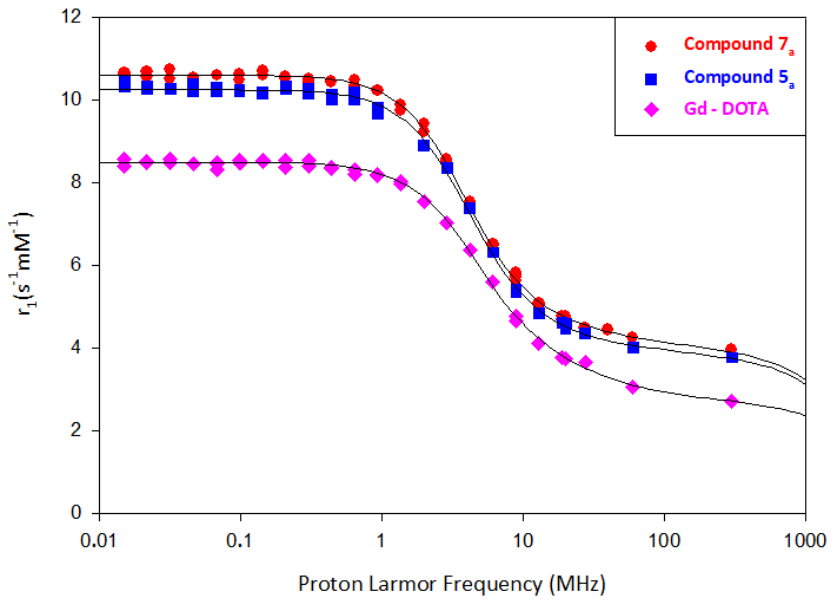
Figure 1. Nuclear magnetic relaxation dispersion (NMRD) profiles of the compounds 5 a and 7 a compared to the DOTAREM ® profile fitted with the Solomon and Bloembergen theory. The parameters extracted from these profiles are listed in Table 1.